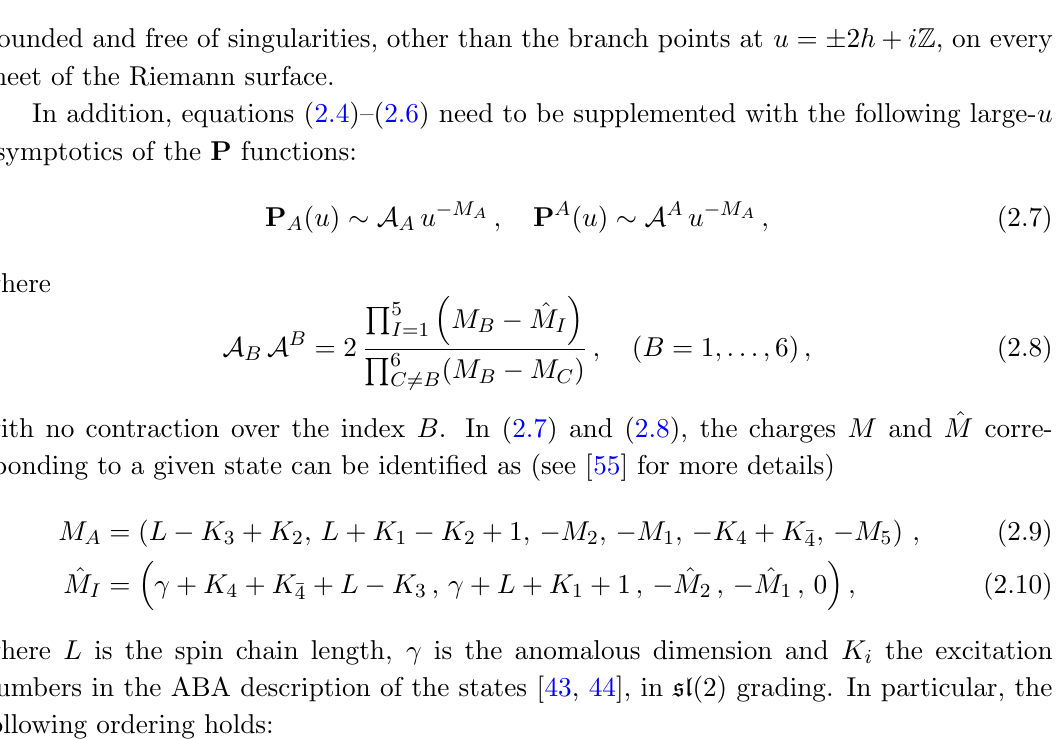
Figure 1 . Cut structure of the P and Q functions in the physical Riemann